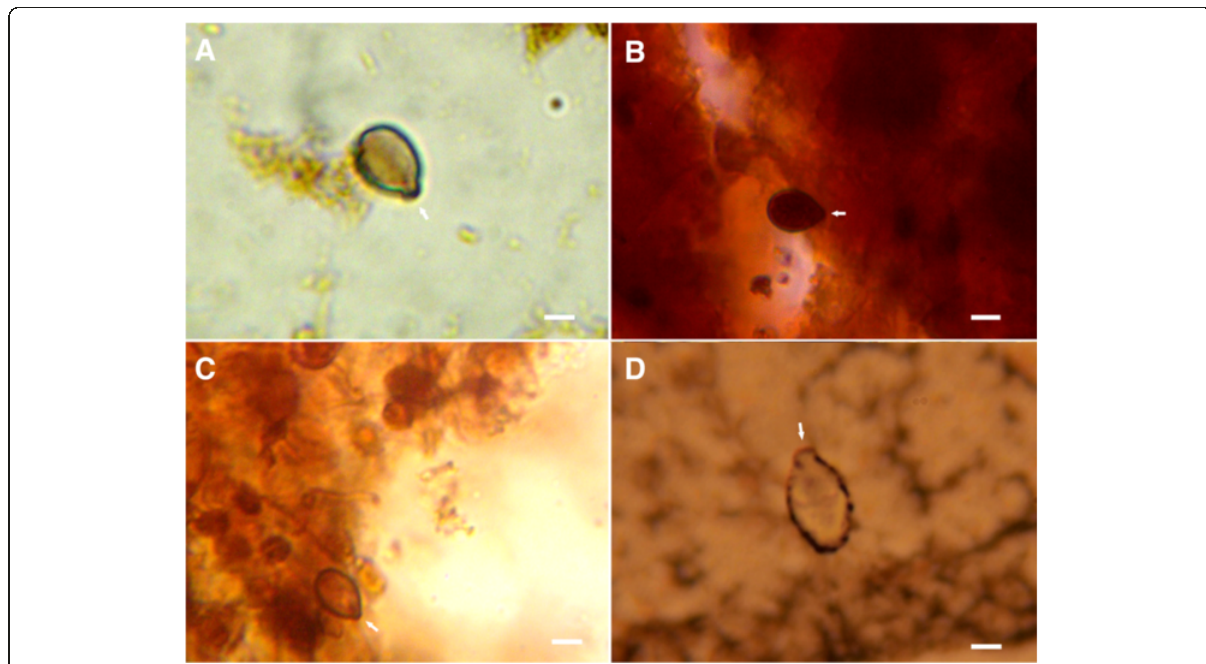
Fig. 6 Nematocytes of C. tagi viewed with von Kossa staining sing optical microscopy. The black circle around or dots inside nematocytes are considered positive for calcium salts. Arrows highlight operculum. a and d Euryteles. b and d Isorhizae. Bars: ( a ) 4 μ m; ( b and c ) 5 μ m; ( d ) 3 μ